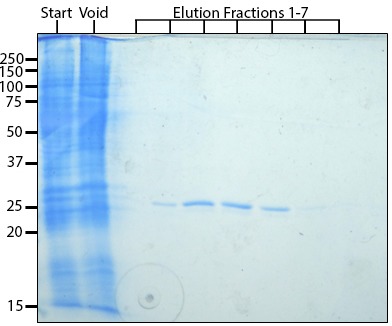
Purified X. laevis RhoGDI protein.Coomassie stain of 12% SDS-PAGE to assess purity of FLAG-GDI; lane 1: start, lane 2: void, lanes 3–10: elution fractions.